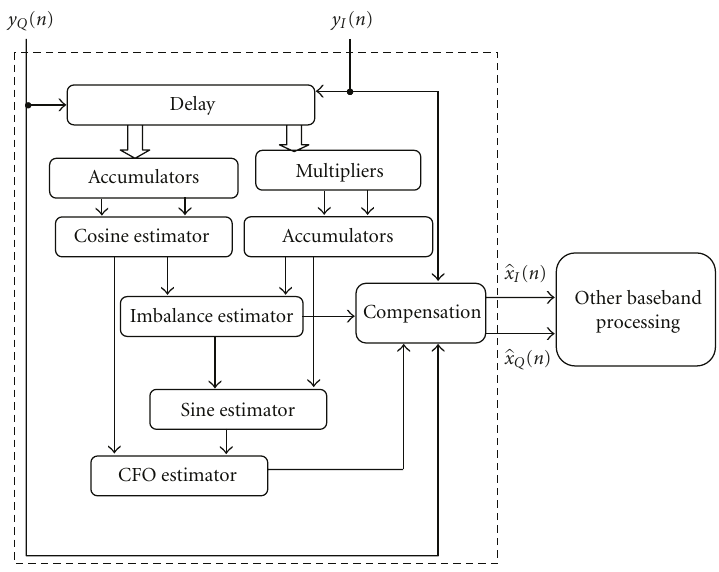
Figure 3: Implementation structure of the proposed